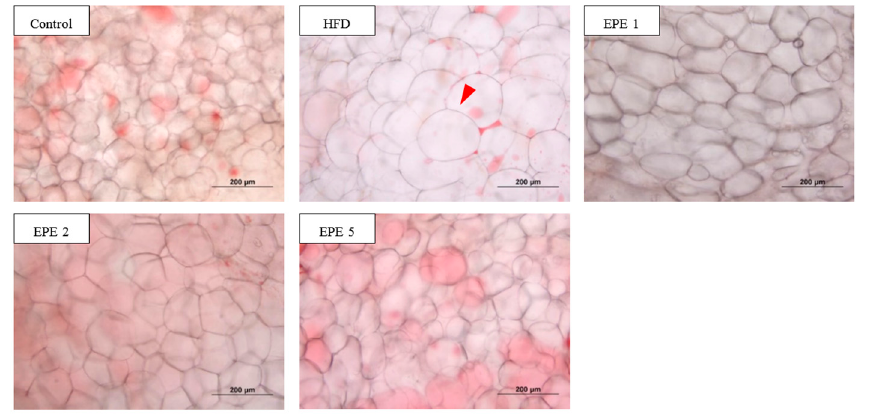
Figure 2. Effects of Echinacea purpurea extract on adipocyte morphology in HFD-induced obese rats after 5 weeks. Table 1. Effects of Echinacea purpurea ethanol extract on adipocyte diameter in HFD-induced obese rats after 5 weeks.